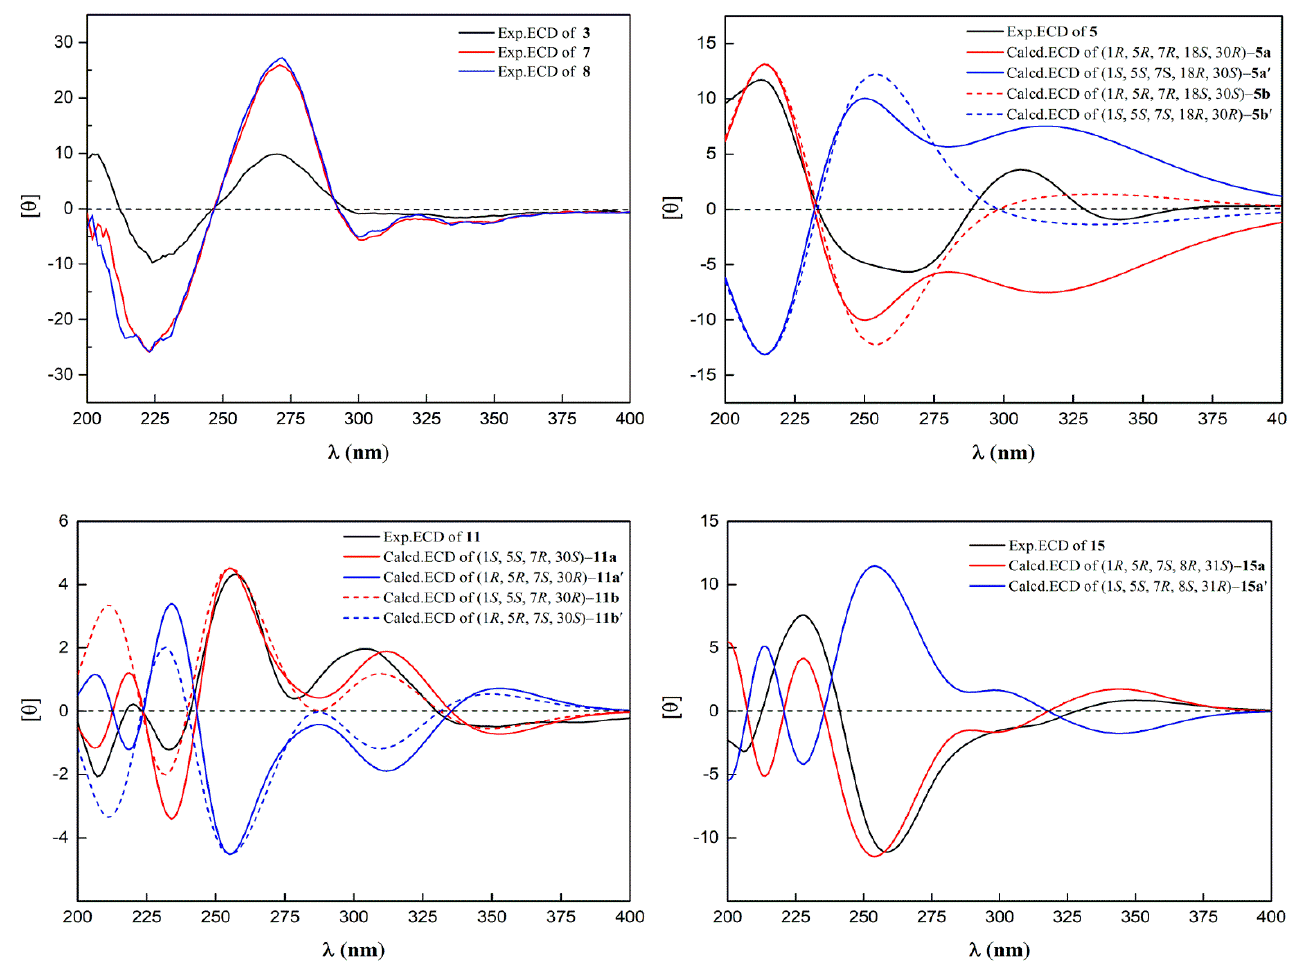
Figure 3. Calculated and experimental ECD spectra of compounds 3 , 5 , 7 – 8 , 11 , and 15